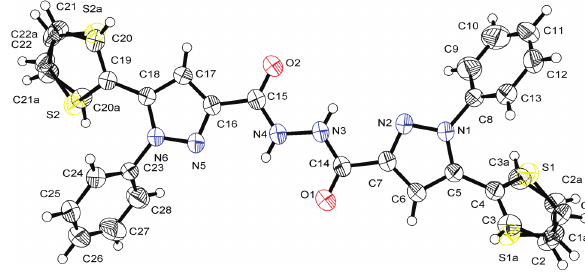
Table 1: Data collection and handling.